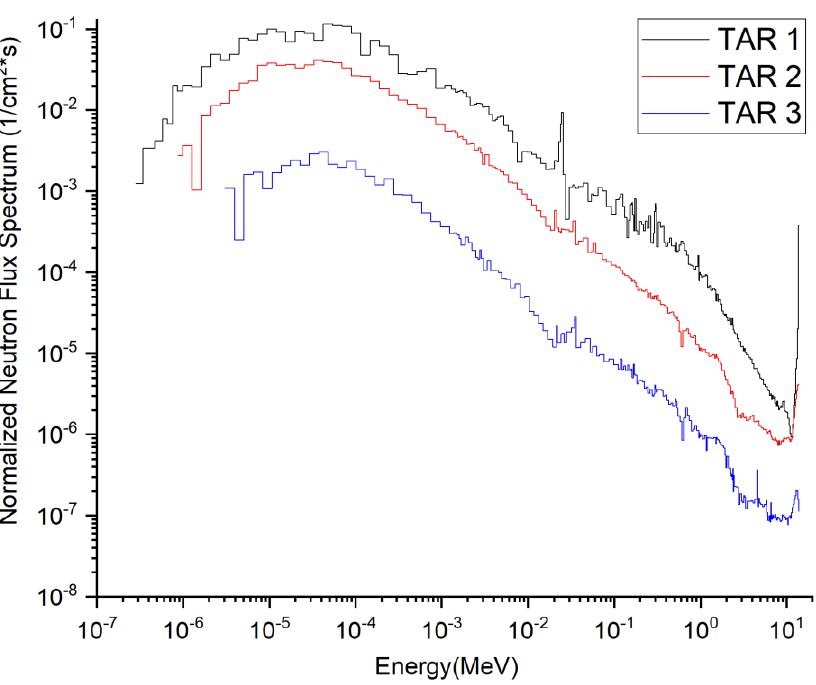
Molecules 2023 , 28 , x FOR PEER REVIEW Figure 2. Total flux density spectra of neutrons at the incident surfaces of the three target segments.